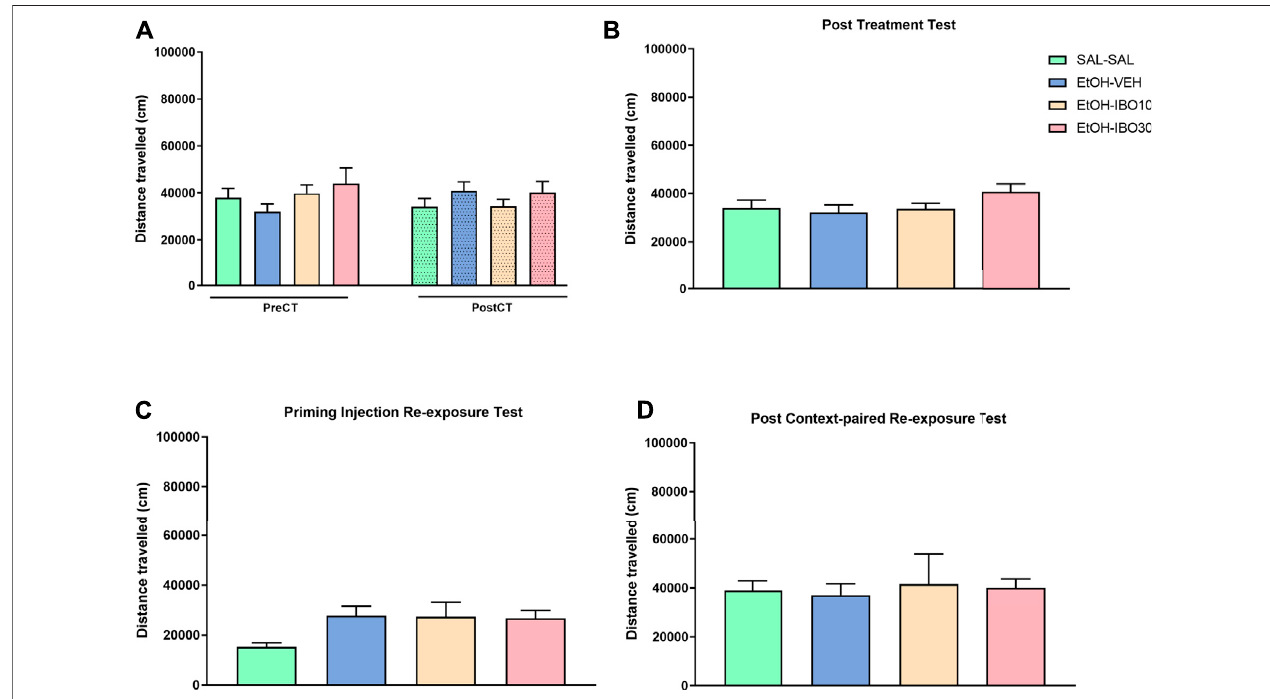
FIGURE 5 | Effects of treatment with ibogaine on the reinstatement of ethanol-induced conditioned place preference (CPP). (A) Total distance traveled in the CPP apparatus during the pre-conditioning test (preCT, n (cid:2) 24per group) and the post-conditioning test (postCT, n (cid:2) 24 per group) following conditioning with saline (SAL, i. p.) orethanol(EtOH,1.8 g/kg, i.p.)intheCPP apparatus. (B) Totaldistancetraveledduring adrug-free post-treatmenttest ( n (cid:2) 24per group) after treatment withsaline (SAL, i. p.), vehicle (VEH, oral administration) or ibogaine (IBO, 10 or 30 mg/kg, oral administration) in the ethanol-paired compartment. (C) Total distance traveled duringapriminginjectionre-exposuretestinwhichallgroupsreceivedapriminginjectionofethanol(EtOH,1.8 g/kg,i.p.)andhadfreeaccesstotheCPPapparatus( n (cid:2) 8pergroup). (D) Totaldistancetraveledduringadrug-freetestconducted24 hafteracontext-pairedre-exposure,inwhichsubjectsreceivedaninjectionofsaline(SAL- SAL group, n (cid:2) 16) or ethanol (EtOH, 1.8 g/kg, remaining groups, n (cid:2) 16 per group) and were con fi ned to the compartment previously conditioned to ethanol. Data are reported as means ±